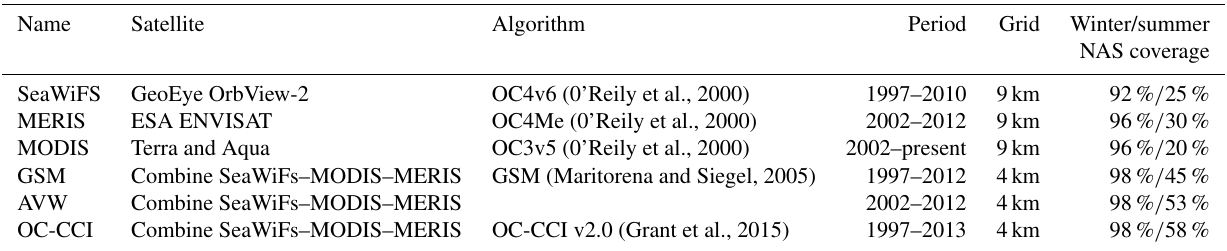
Table 1. Main characteristics of ocean colour satellite products used in the present study. Name Satellite Algorithm Period